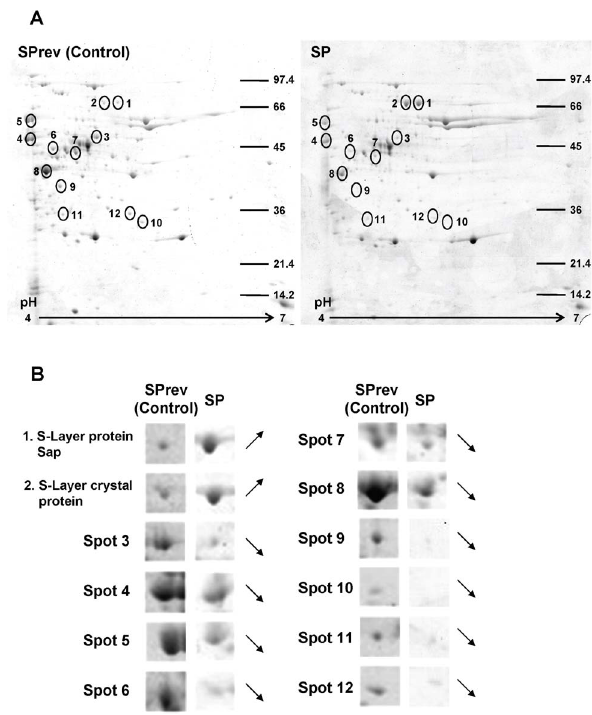
Figure 4. Bidimensional electrophoresis analysis of secreted proteins by Bacilluscereus after a 13 h exposure to Substance P reverse (Control) or Substance P (SP) (10 2 6 M). ( A ) Twelve spots were modified after exposure of the bacteria to SP. ( B ) Two proteins (1 and 2) were over produced whereas the expression of 10 others was down regulated. Identified proteins are presented in Table 1. Results are representative of three independent experiments.